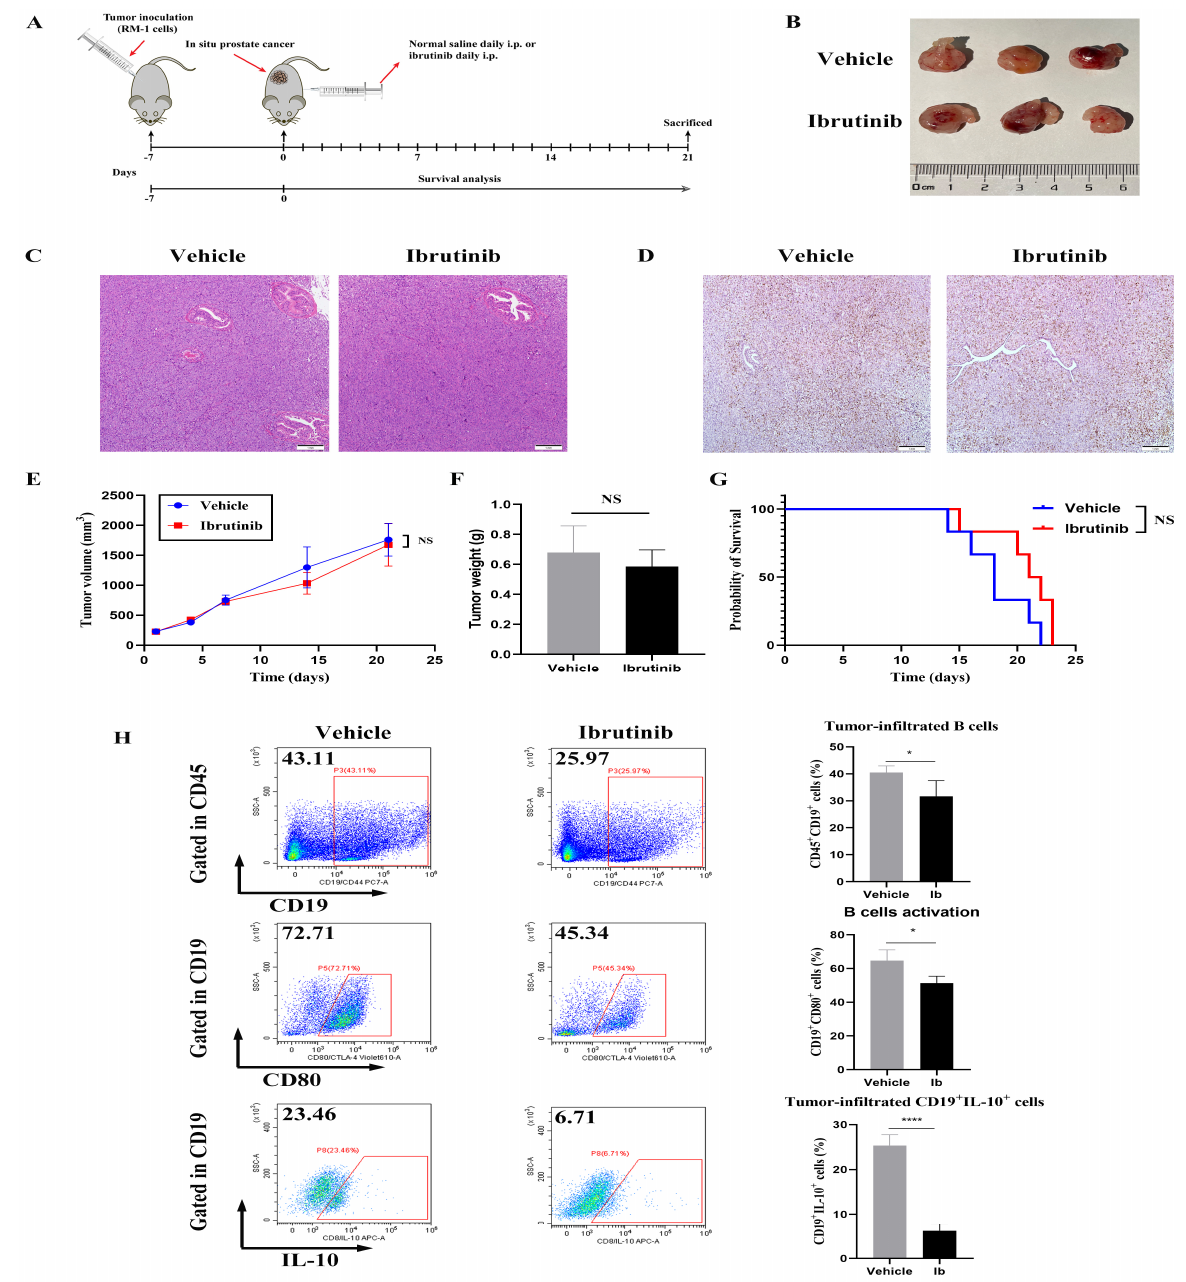
Figure 3. In vivo ibrutinib monotherapy does not suppress PCa growth but hinders TIL-B infiltration and activation. ( A ) Experimental design and treatment strategy. See Materials and Methods for details. ( B ) Representative photographs displaying the gross appearance of RM-1 tumors in mice when sacrificed. ( C ) H&E staining shows inconspicuous pathological changes after treatment with ibrutinib (original magnification: 100 × ). ( D ) IHC staining shows unchanged Ki67 expression in both groups (original magnification: 100 × ). ( E ) Tumor volumes of mice in both groups were recorded at the indicated time points ( n = 4). ( F ) Tumor weights of mice in both groups were measured when sacri fi ced ( n = 4). ( G ) Kaplan-Meier survival curve of tumor − bearing mice treated as indicated ( n = 6). ( H ) Flow cytometry analysis of TIL-Bs. Ibrutinib administration signi fi cantly inhibited the in fi l- tration and activation of TIL-Bs in mouse orthotopic PCa models ( n = 4). A p value less than 0.05 was considered statistically signi fi cant. TIL-Bs, tumor − in fi ltrating B cells. *, p < 0.05; ****, p < 0.0001. These results suggested that ibrutinib indeed suppressed B cell in fi ltration and func- tion in mouse metastatic PCa models but failed to control tumor growth. We further